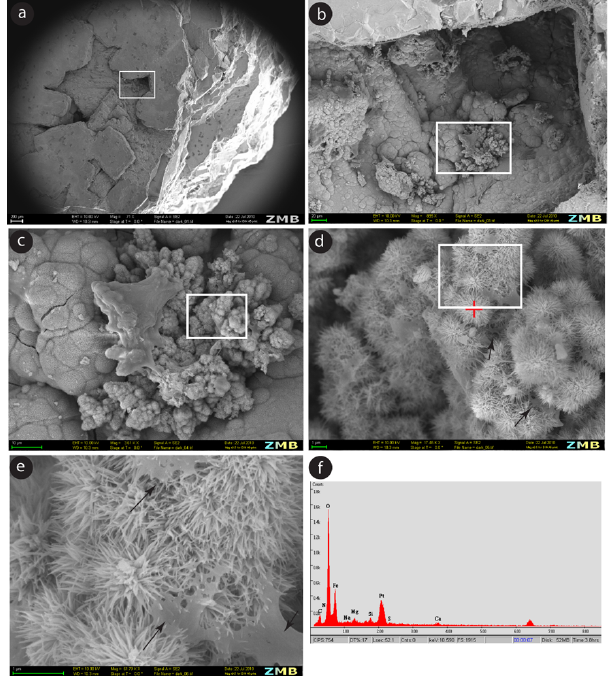
Fig. 11. Secondary electron images of the surface of the stalactite: (a) a thin layer cover calcite surface that includes microborings (ar- rows). They consist of solitary cells that are spherical in shape and average 1 to 10µm in diameter; (b) microborings include open bor- ings (1) and resin casts (2); (c, d) elemental analyses indicate that open borings are made of low-magnesium calcite, whereas resin casts are made of Fe, O and Si; (e) the thin layer-covering calcite crystals are composed of nanofilaments forming flakes; (f) elemen- tal analyses of this layer reveal that it is made of Fe, Si and